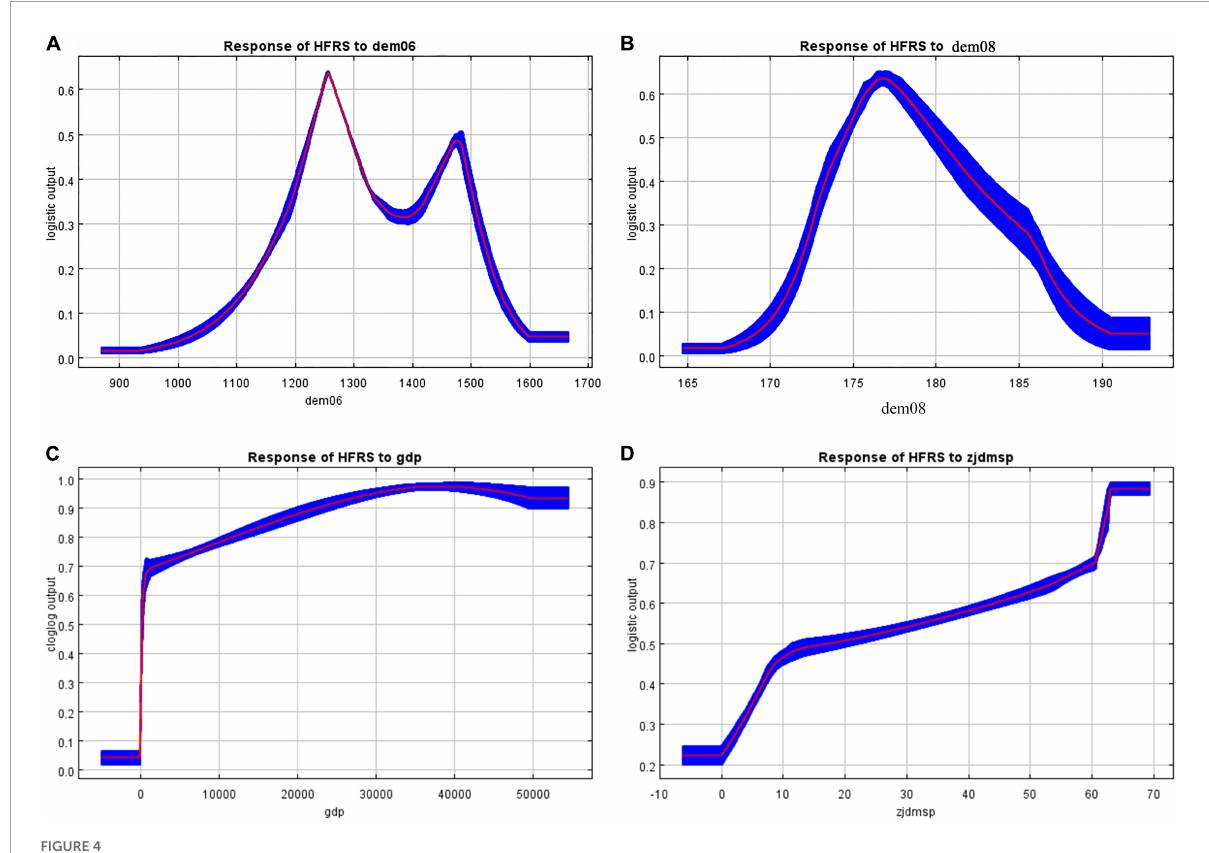
FIGURE4 The response curves contributed to the MaxEnt model of